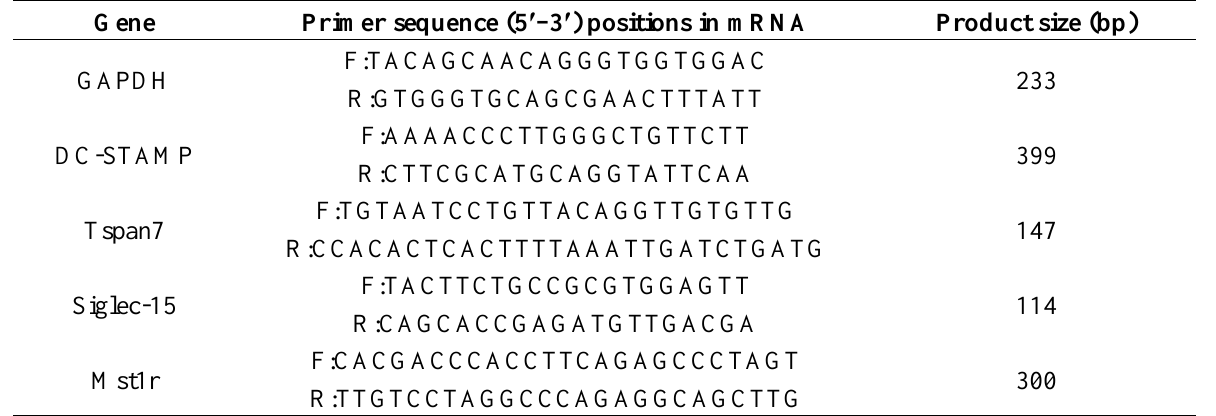
Table 1. Primer sequences used for real-time PCR.